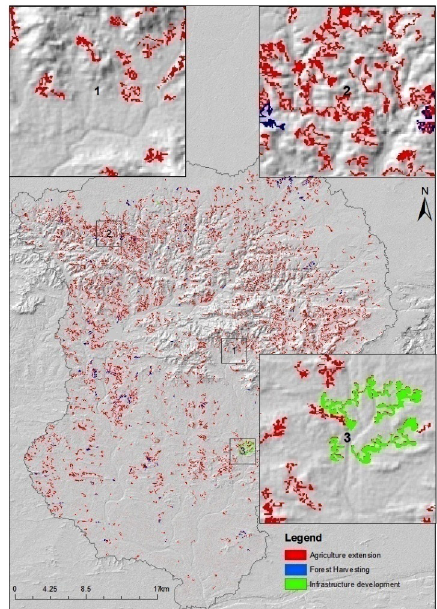
Figure 4. Mapped deforestation areas using automatic change detection analysis